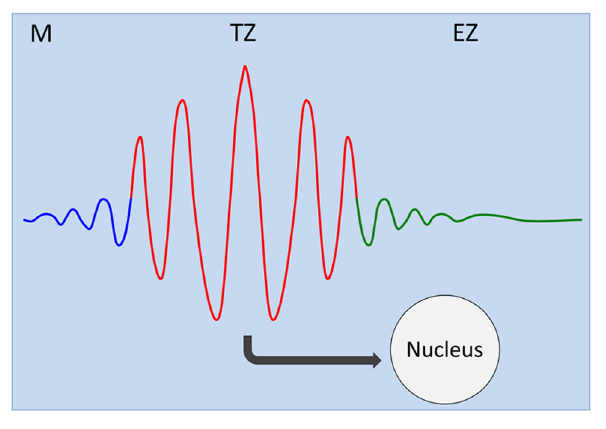
FIGURE 1 |Transition zone as oscillatory zone. Oscillations of the plasma membrane electrical potentials generate, via multiple feedback loops with membrane associated cytoskeleton, self-sustaining and self-regulating cellular oscillator (Shabala etal., 1997, 2006; Mancuso and Boselli, 2002; Shabala, 2003; Mancuso etal., 2005, 2007; McLamore etal., 2010a,b; Mugnai etal., 2012). Oscillatory patterns of ion and auxin fluxes at the plasma membrane feed into the oscillations of gene expression in the nucleus (Moreno-Risueno etal., 2010, 2012;Traas andVernoux, 2010; Moreno-Risueno and Benfey, 2011). M, meristem;TZ, transition zone; EZ, elongation